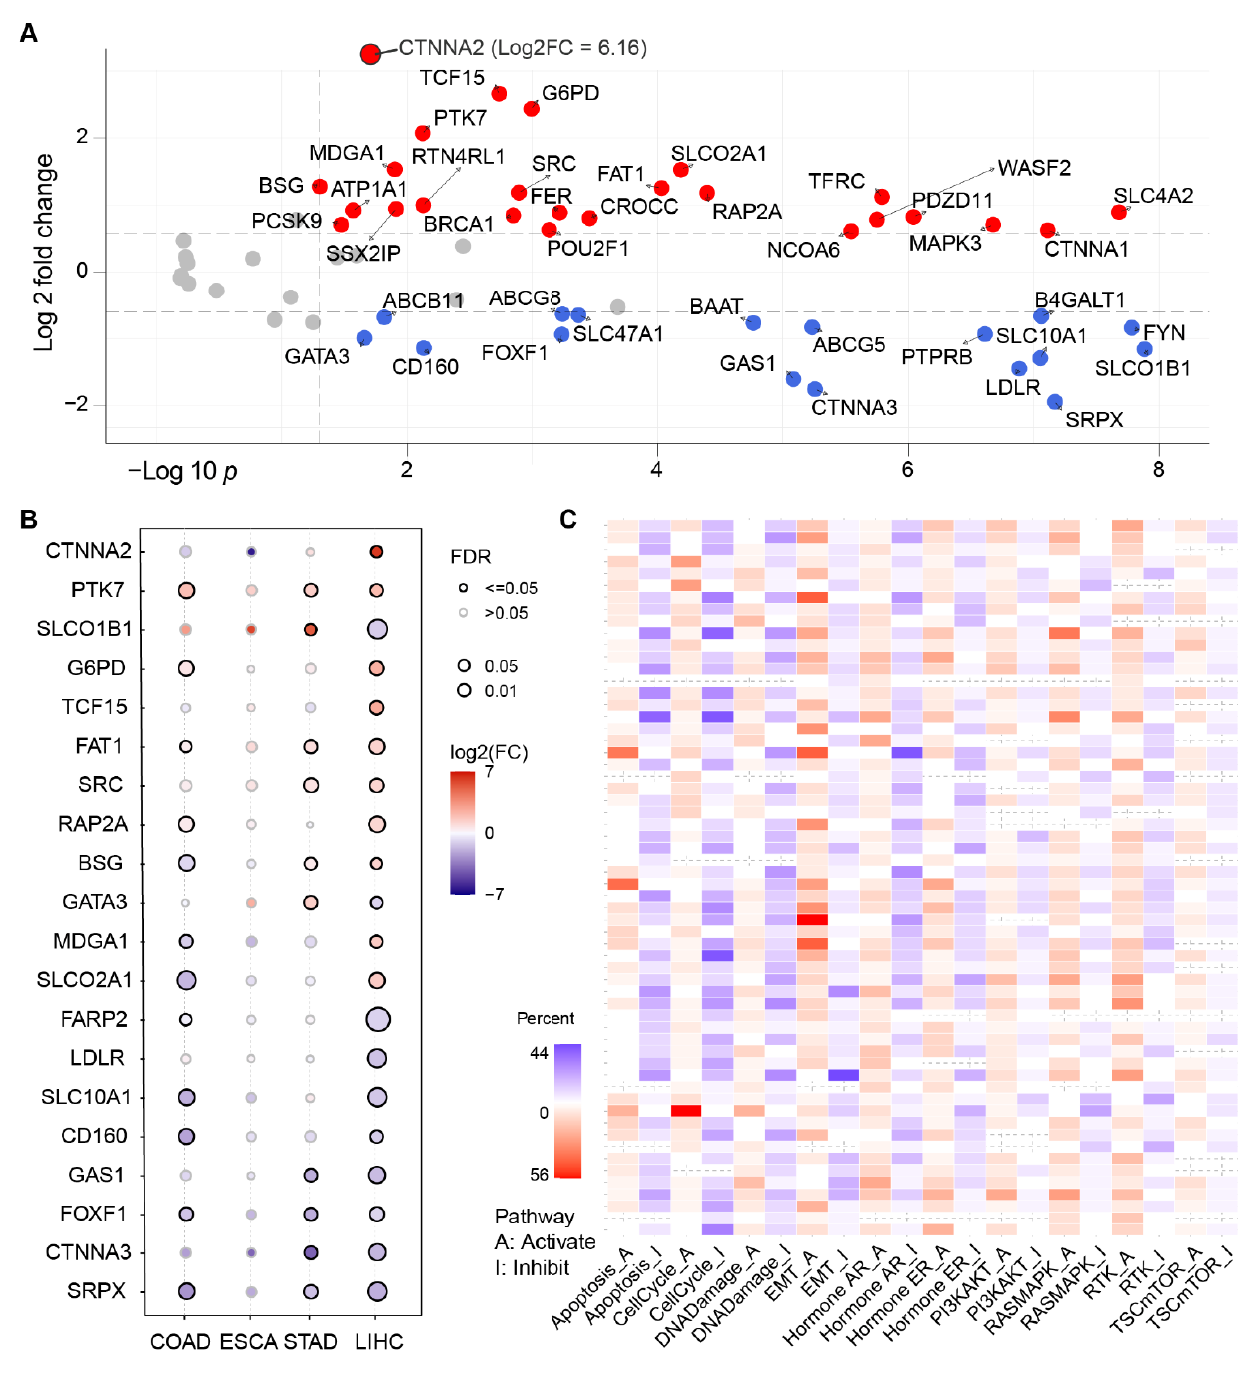
Figure 2. The differential expression analysis of the selected polarity-related genes (PRGs) with clinical value in different tumor tissues and paracancerous tissues of the digestive system from the cancer genome atlas (TGCA) database. ( A ) Volcano plot of 61 PRGs expression change between tumor and matching normal tissues from liver hepatocellular carcinoma (LIHC) with fold change >1.5 and FDR p < 0.05. CTNNA2 was separately illustrated. ( B ) The mRNA expression level of selected polarity-related genes across colon adenocarcinoma (COAD), esophageal carcinoma (ESCA), stomach adenocarcinoma (STAD), and LIHC datasets. The larger circle, the more statistically significant. ( C ) EMT and cell cycle pathway are the mostly disrupted by the selected polarity genes across all cancer types deposited in TCGA. The color in each cell indicates that the percentage of altered pathway occurrence in evaluated cancer types. Red for activation, blue for